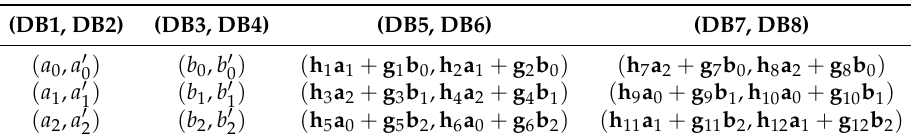
Table 13. Answers for W 1